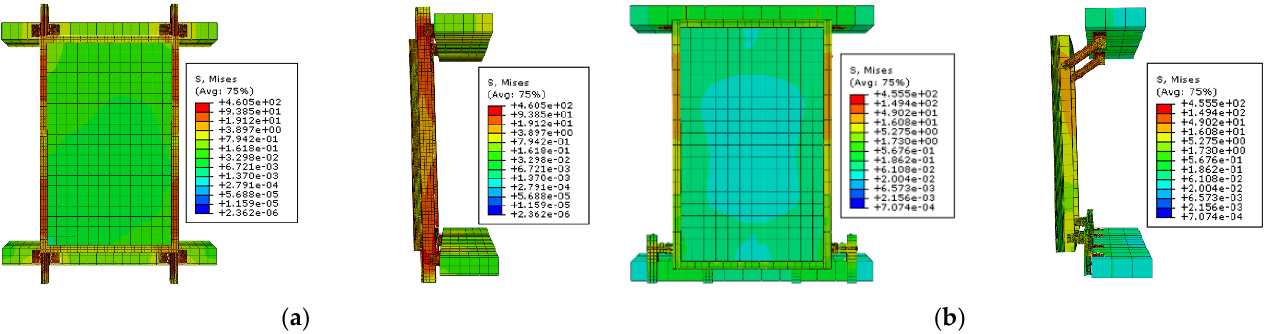
Figure 27. Comparison of appearance changes under applied Y -axis inter-story drift: ( a ) non-seismic curtain wall module; ( b ) seismic curtain wall module.